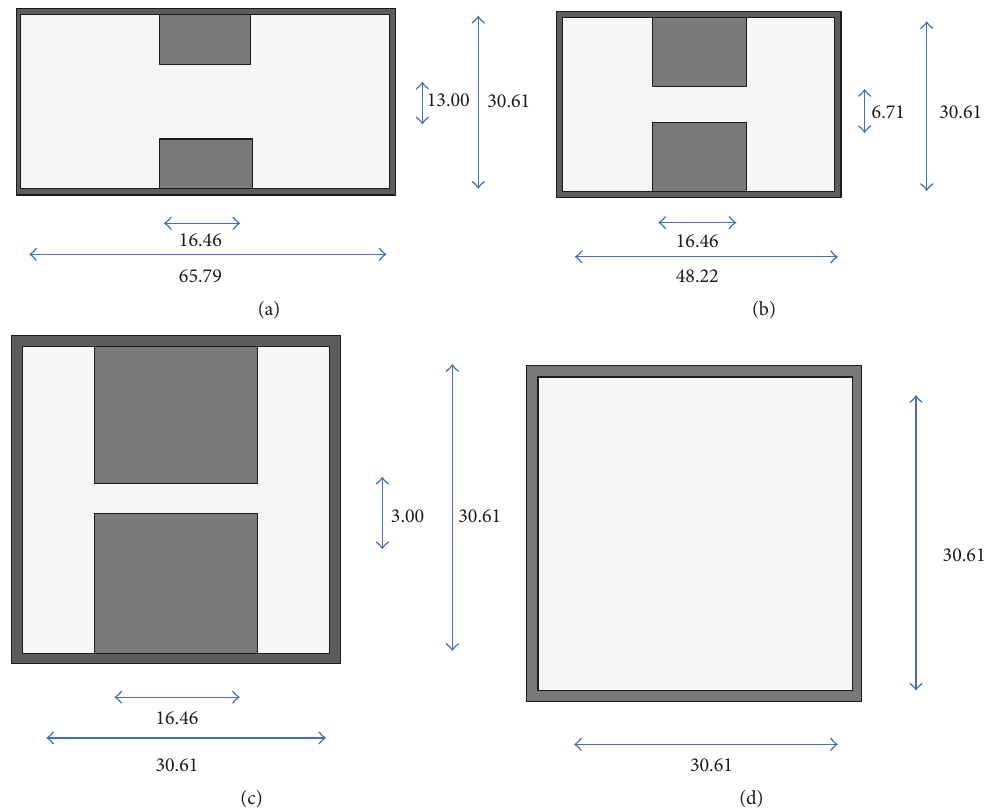
Figure 3: Dimension of each waveguide (unit: mm): (a) WRD-200, (b) transformer, (c) ridge WR, and (d) WR.